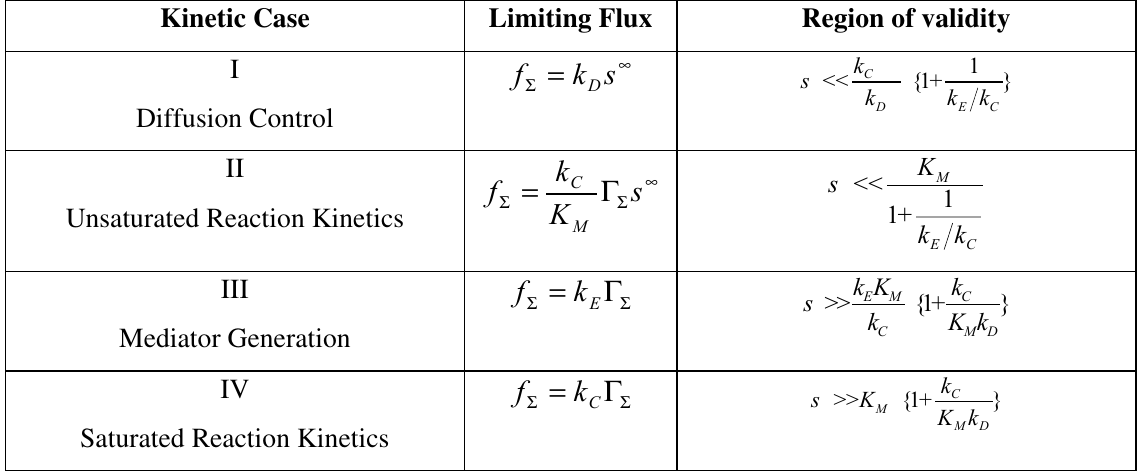
Figure 12 . Kinetic case diagram for the adduct formation mechanism for the limiting case of ξ >> 1. Table 1. Summary of limiting kinetic expressions for reaction flux and condition of validity for each rate limiting